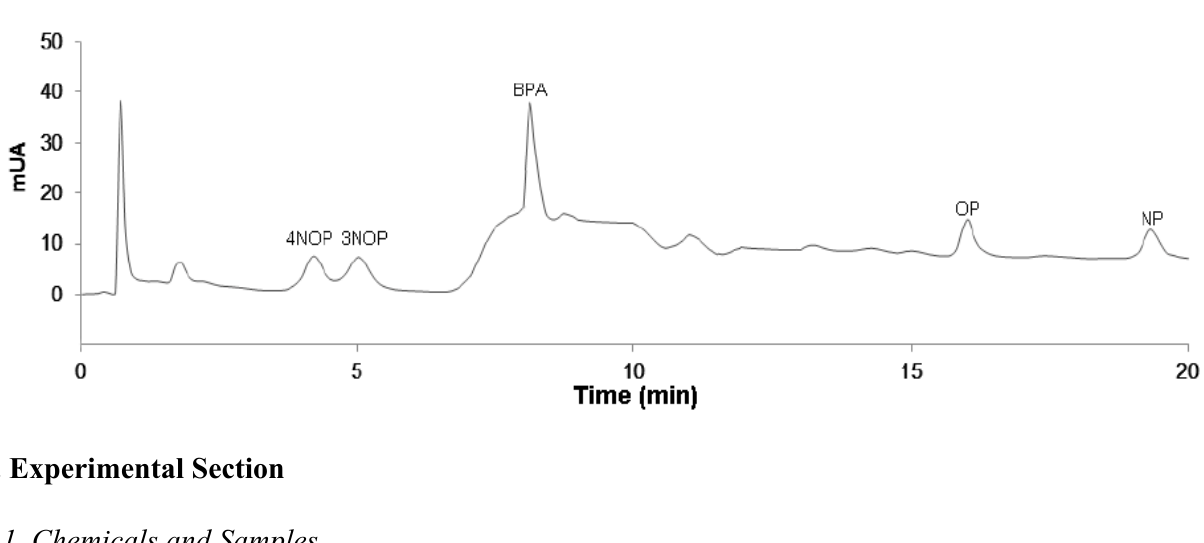
Figure 3. Chromatogram obtained from assays performed in a surface water spiked